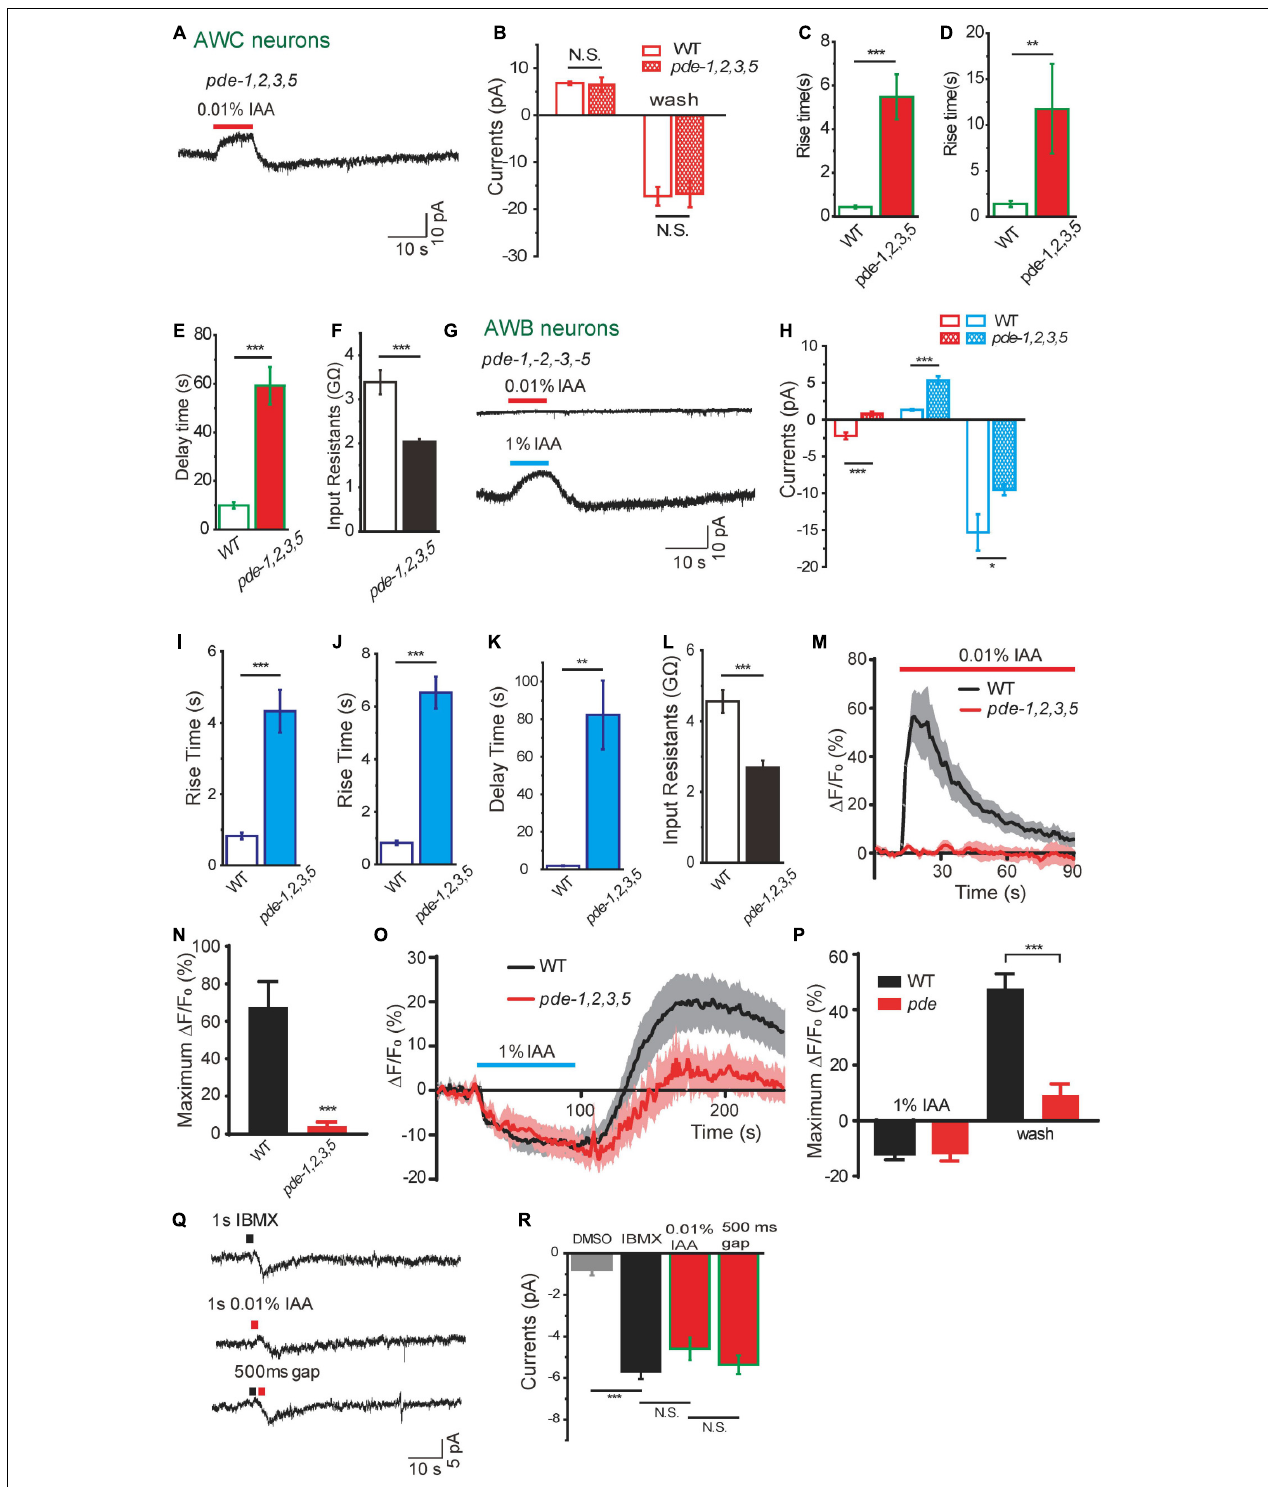
FIGURE 5 | Dual functions of phosphodiesterases in intensity-dependent olfactory encoding. (A–F) 0.01% IAA-induced currents from AWC neurons in pde–1(nj57);–2(nj58);–3(nj59);–5(nj49) quadruple mutants. (A) Representative trace. (B) The amplitude of olfactory currents was normal in pde quadruple mutants. The rise time of both outward currents (C) and inward currents (D) become slower, and the decay time of inward currents induced by odorant removal become much longer (E) . (F) Input resistance of AWC neurons was decreased in pde quadruple mutants. n ≥ 6. (G–L) 0.01 and 1% IAA-induced currents from